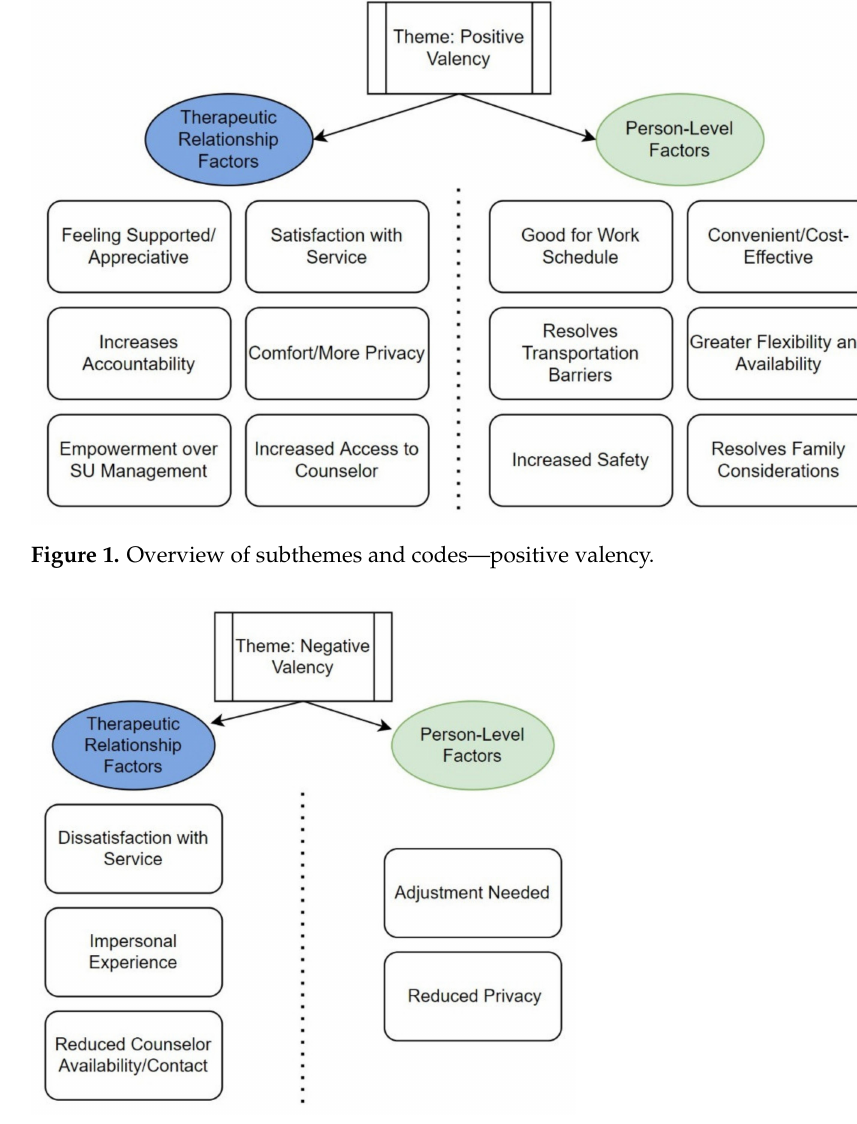
Figure 2. Overview of subthemes and codes—negative